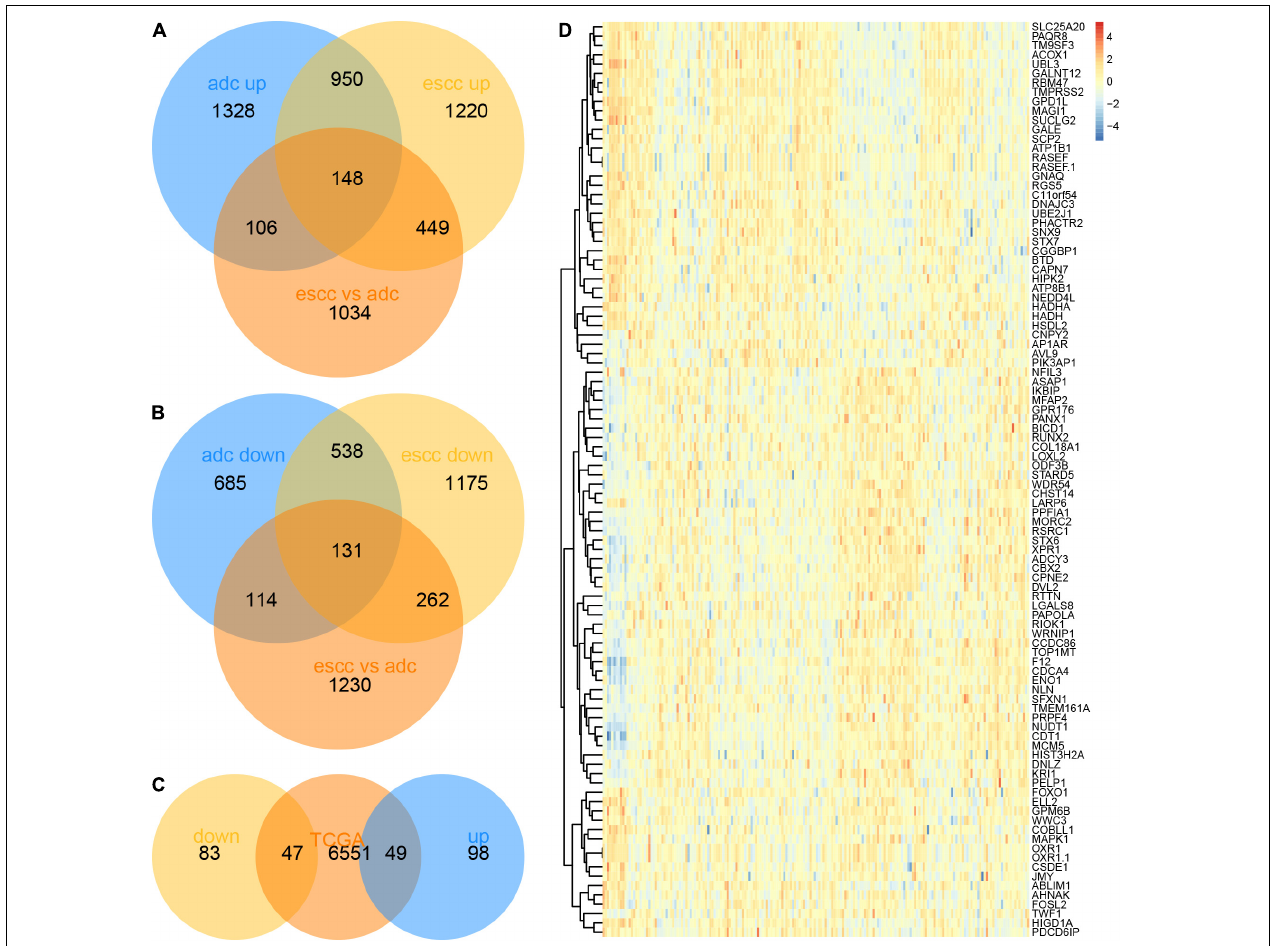
FIGURE 5 | Identification of hub tumor progression genes between esophageal adenocarcinoma (EA) and esophageal squamous cell carcinoma (ESCC). (A) One hundred forty-seven common induced genes that was also differently expressed between EA and ESCC were identified using Venn diagram. (B) One hundred thirty common reduced genes that was also differently expressed between EA and ESCC were identified using Venn diagram. (C) The differently expressed genes between esophageal cancer (EC) and normal samples were shown using heatmap. (D) Forty-seven common reduced and 49 common induced genes were also differently expressed in EC samples compared to normal samples using The Cancer Genome Atlas (TCGA)